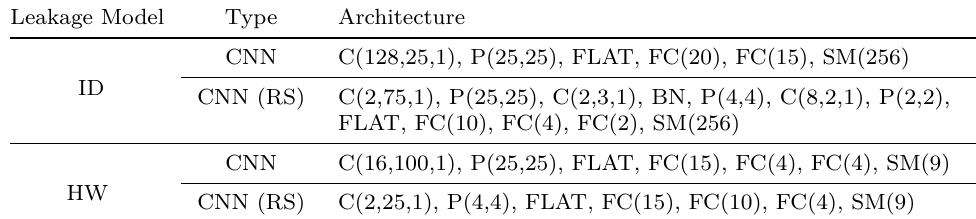
Table 10: The best found architectures for the ASCAD fixed key dataset.